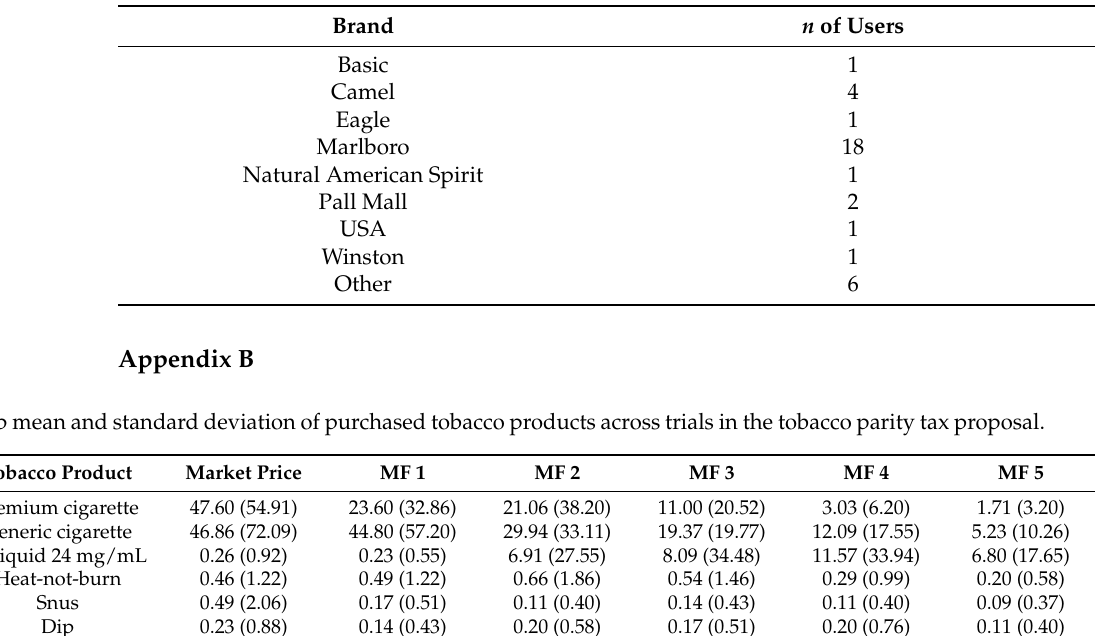
Table A1. Participants’ usual cigarette brands.